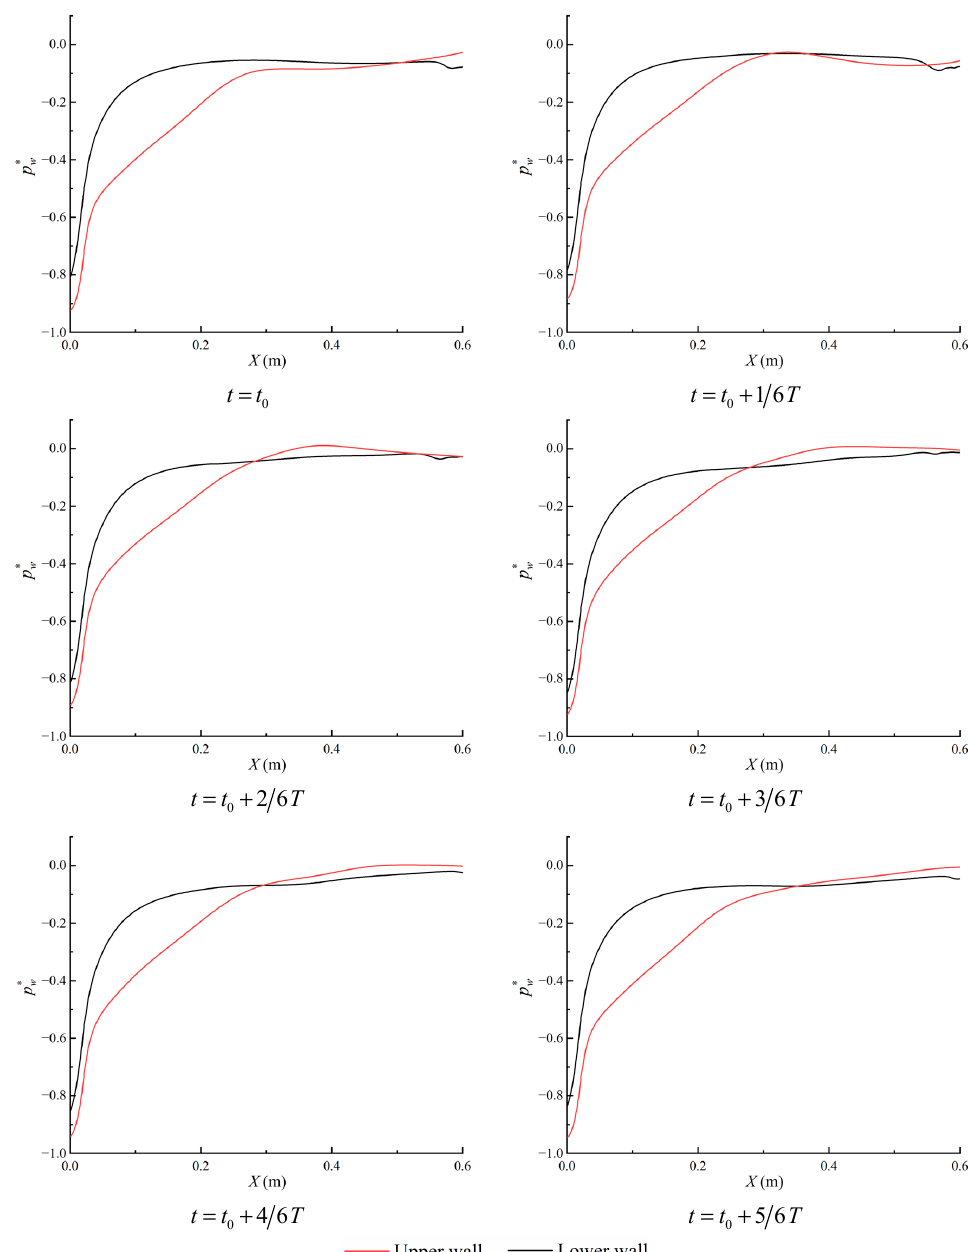
Figure 11. Distributions of wall pressure along diverging walls of the vaned diffuser.